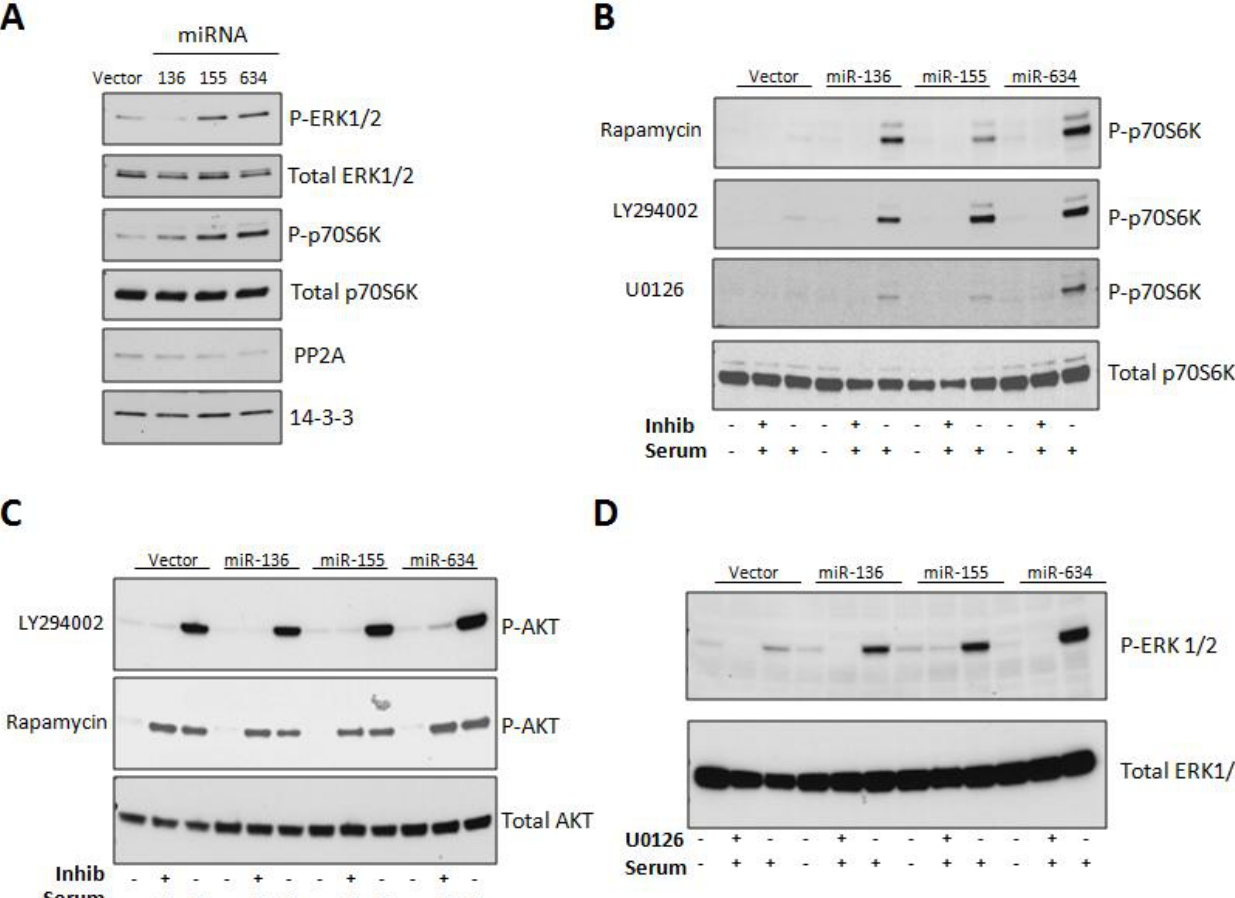
Figure 3. Expression of microRNAs (-136, -155, or -634) up-regulate mTOR signaling in an AKT- and ERK1/2-dependent manner. ( A) Western blot analysis of cells nucleofected with miRNA-expressing plasmids. Western blot of phospho- and total proteins was performed on lysates from LN229 cells that were transiently nucleofected with empty or miRNA-expressing plasmids for 48 h. ( B) Western blot of phospho-p70SK (T389) and total p70SK. Western blot was performed on lysates from LN229 cells that stably express empty or miRNA-expressing plasmids and were pretreated with specific inhibitors (50 µM LY294002, 10 nM Rapamycin, or 15 µM U0126) for 1 h followed by stimulation with 10% serum for 1 h. ( C) Western blot of phospho- and total AKT (S473). Cells were treated as described in panel B. ( D) Western blot of phospho- and total ERK1/2 (T202/Y204). Cells were treated as described in panel